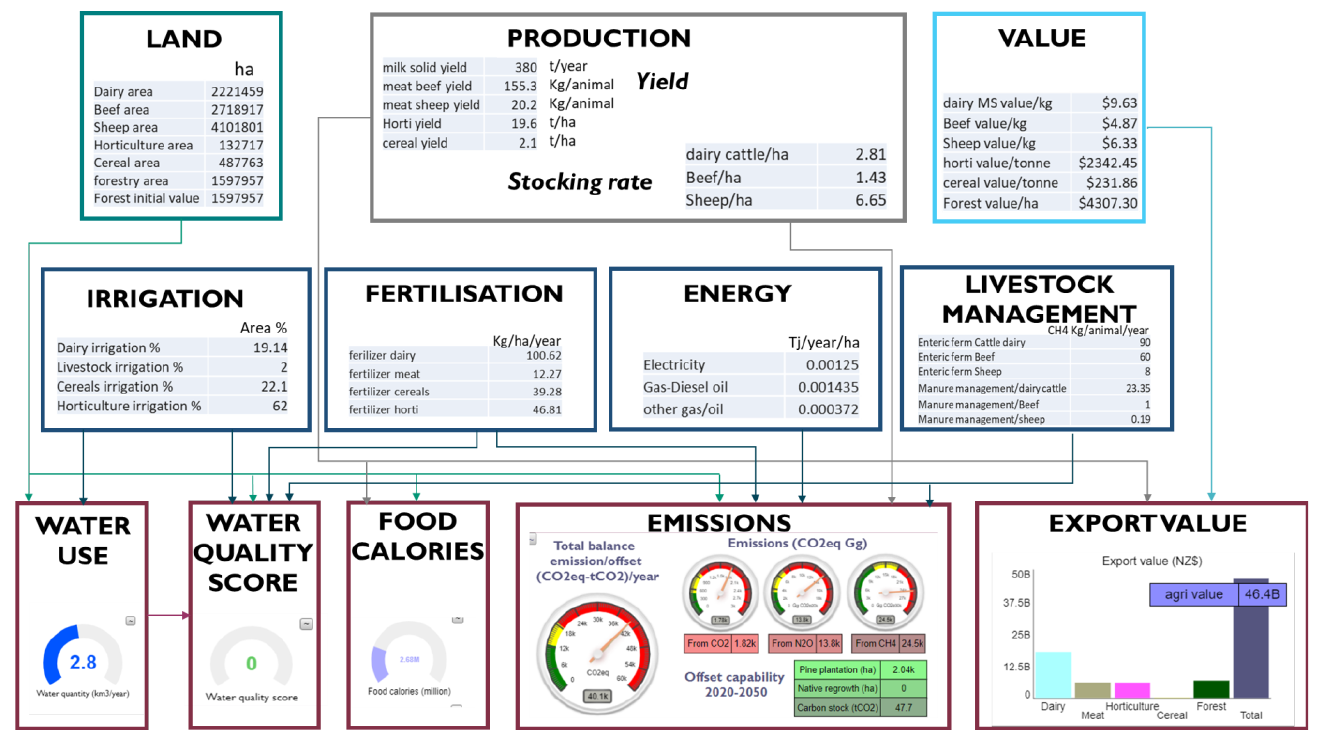
Figure 3. Model process description: relationships between input parameters, technological parameters, and output indicators. Values are for 2019.